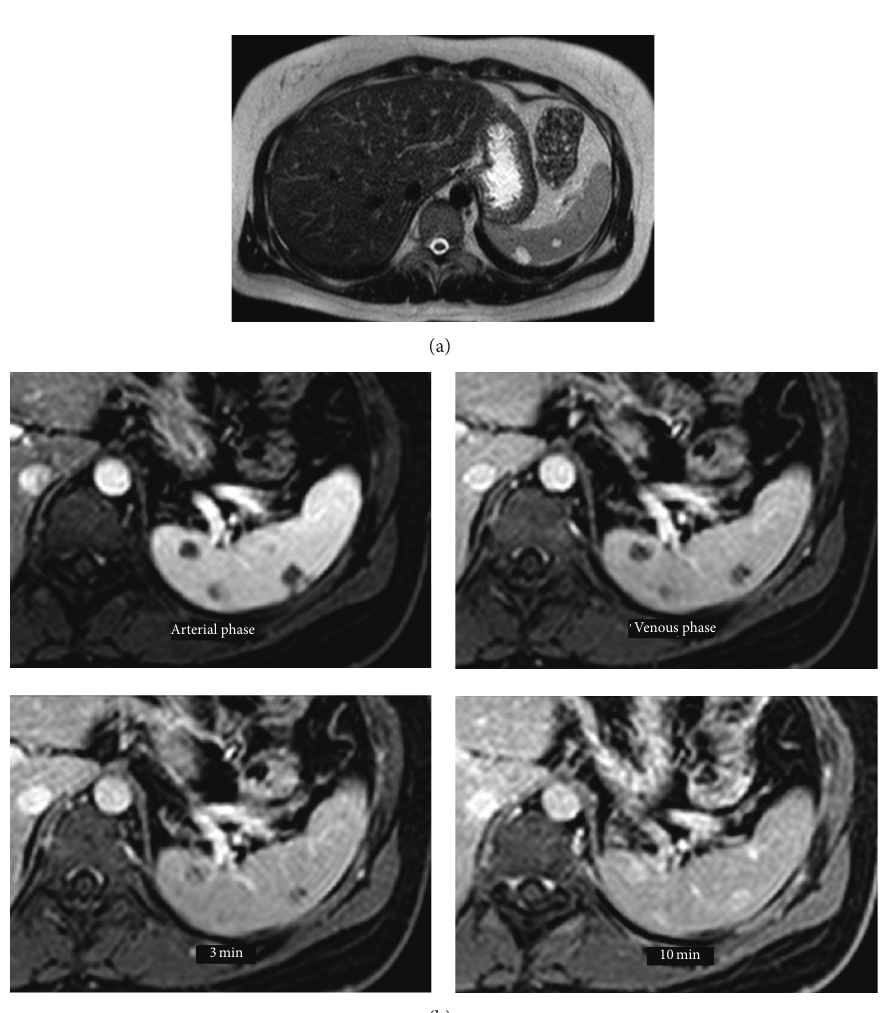
Figure 1: (a) Multiple lesions throughout the spleen up to 15 mm in size. They have a high signal on T2 and SPIR. (b) Signal intensity was low on T1 sequences. After gadolinium contrast, no attenuation was seen in the arterial phase, heterogeneous contrast enhancement in the portal venous phase, and after 3 minutes the enhancement is stronger in the periphery than central in the lesions. After 10 minutes the signal is stronger in the lesions than the surrounding splenic tissue. The signal pattern is in keeping with hemangiomas. On histopathological examination the diagnosis of LCA was